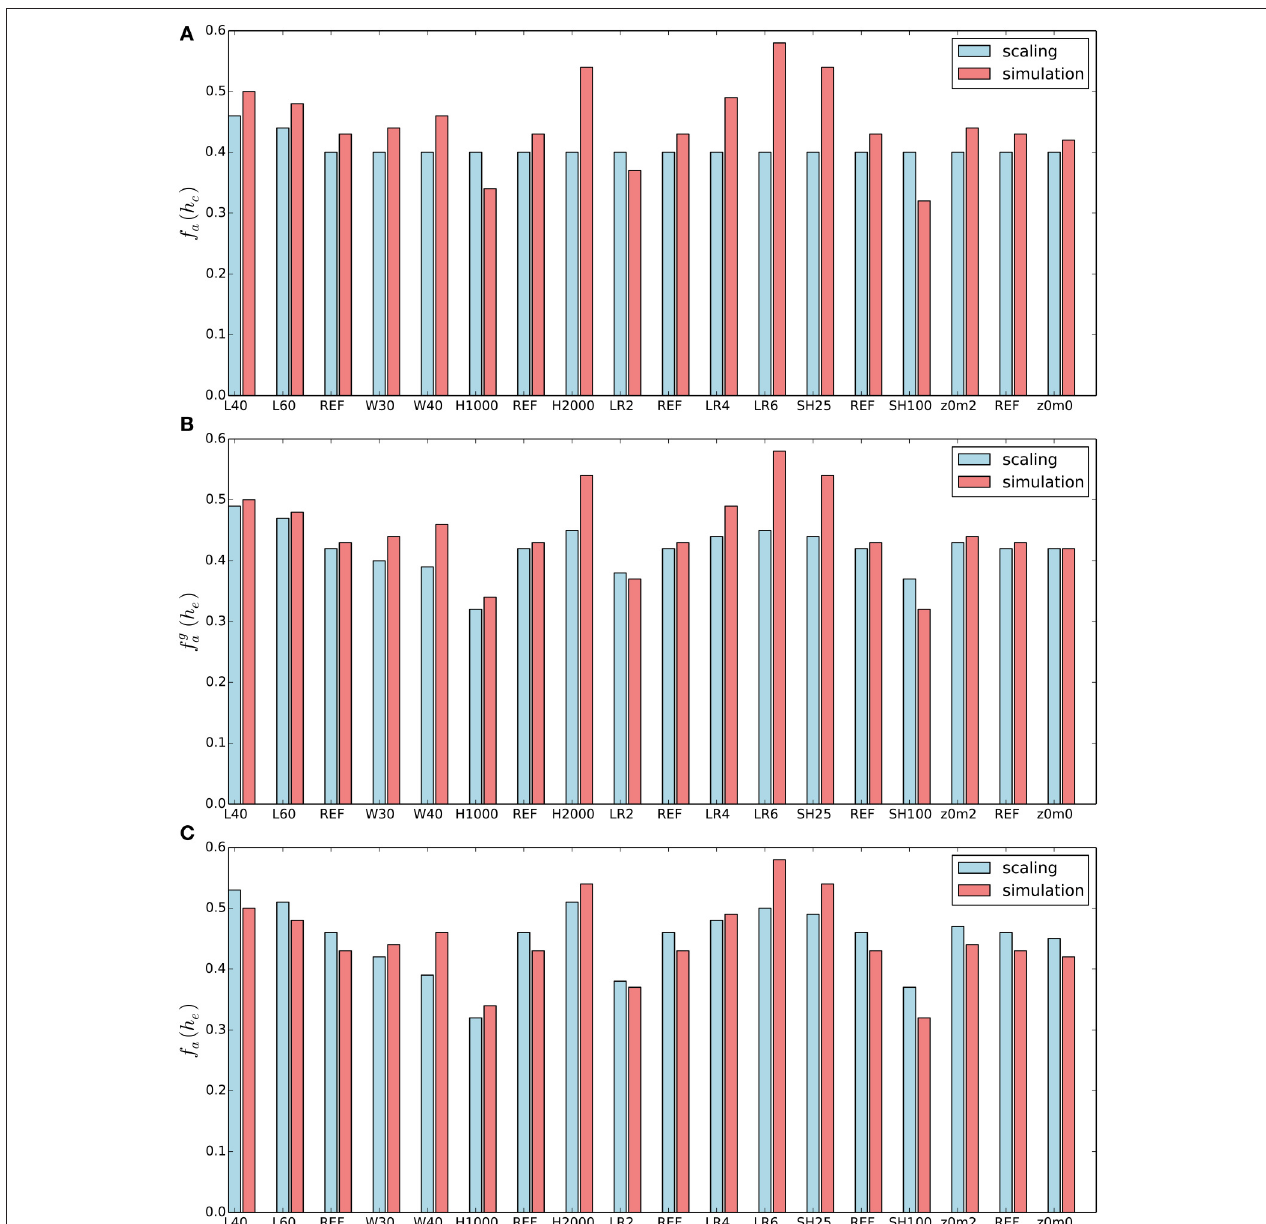
FIGURE 6 | Scaling the advective heat flux: comparison of different approximations of f a with the diagnosed value from the numerical simulations. (A) basic approximation: f a = f a ( h c ) , (B) improved estimate with f a = f g a ( h e ) , (C) improved estimate with f a = f a ( h e )